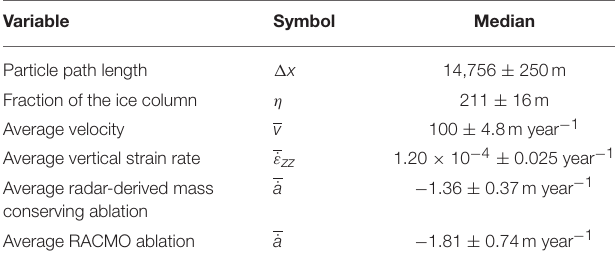
TABLE 2 | Median of observational data used to calculate radar-derived, mass conserving (rMC) ablation rates.